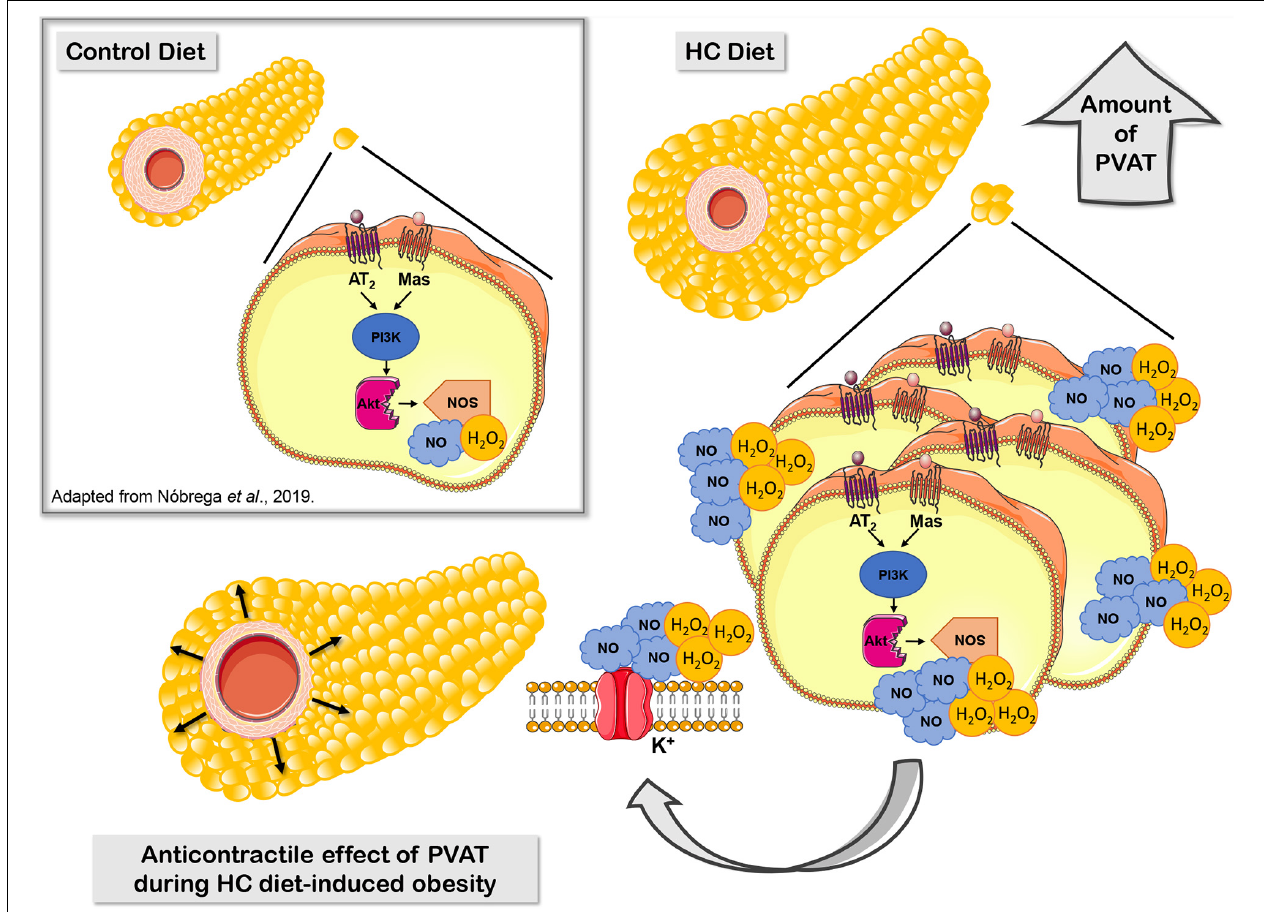
FIGURE 11 | Proposed mechanisms underlying the anticontractile effect of PVAT during HC diet-induced obesity. Signaling cascade triggered by RAS through activation of Mas and AT 2 receptors, PI3K, nNOS, or iNOS that lead to increased production of the vasodilator molecules NO and H 2 O 2 , and subsequently hyperpolarization by opening potassium